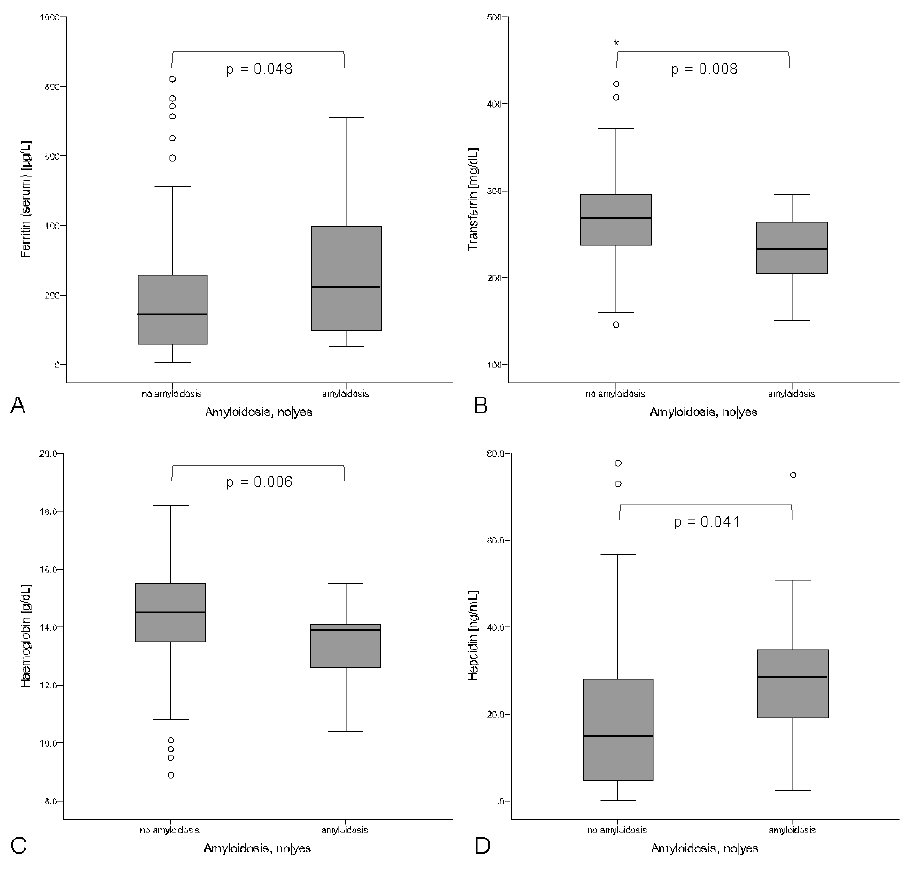
Figure 3: Boxplots of iron metabolism parameters in patients with and without amyloid CMP: Patients with amyloid CMP showed significantly higher ferritin concentrations (223 µg/L [97 – 397] vs. 145 µg/L [59 – 259], p = 0.048 , A) and significantly lower transferrin concentrations (233 mg/dL [205 – 264] vs. 268 mg/dL [239 – 296], p = 0.008 , B) compared to patients with no amyloid CMP. Additionally, haemoglobin concentrations were significantly lower (13.9 g/dL [12.6 – 14.1] vs. 14.5 g/dL [13.5 – 15.5], p = 0.006 , C) and hepcidin concentrations significantly higher (28.5 ng/mL [17.8 – 36.4] vs. 14.7 ng/mL [4.8 – 28.1], p = 0.041 , D) in patients with amyloid CMP compared to patients with no amyloid